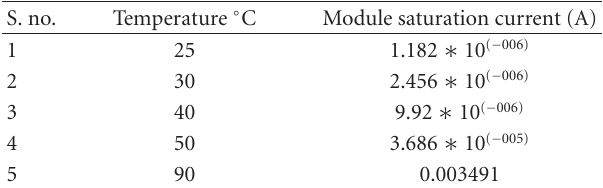
Table 4: I 0 for various